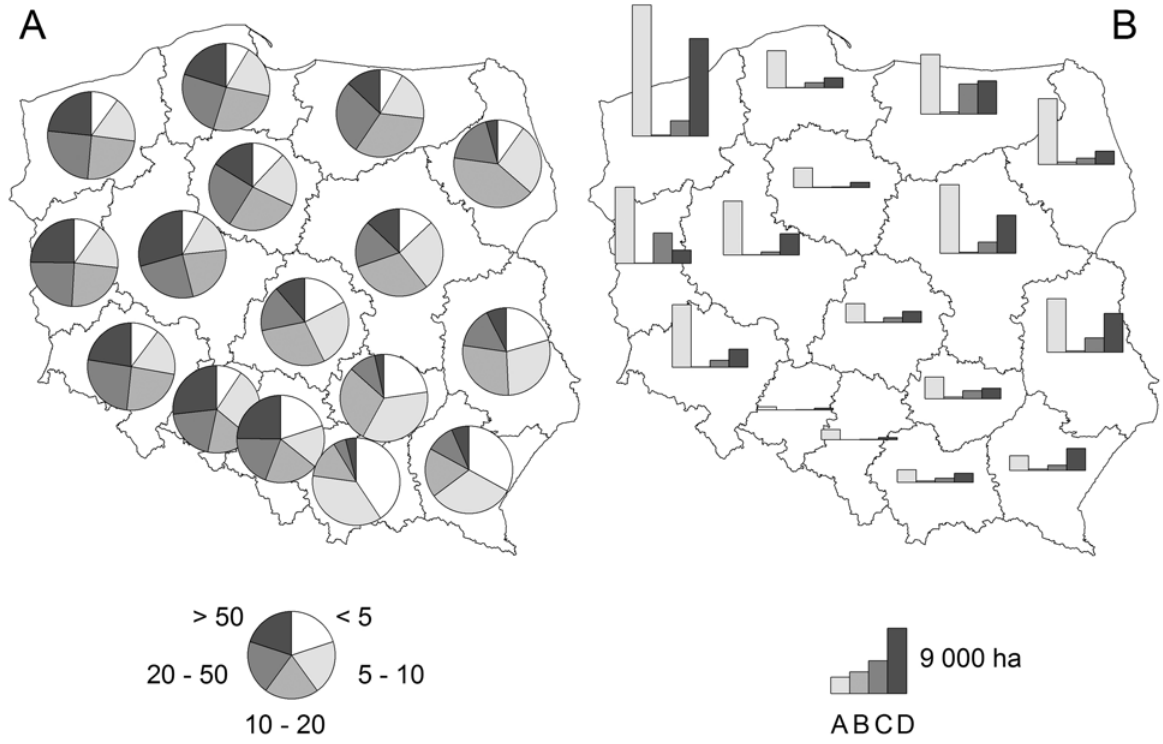
Fig. 11. Structure of organic farms by size group (A) and area of organic crops (%) (B), 2014. A – cereals, B – potatoes, C – vegetables, d – fruit. Source: own calculations based on the IJhArS report